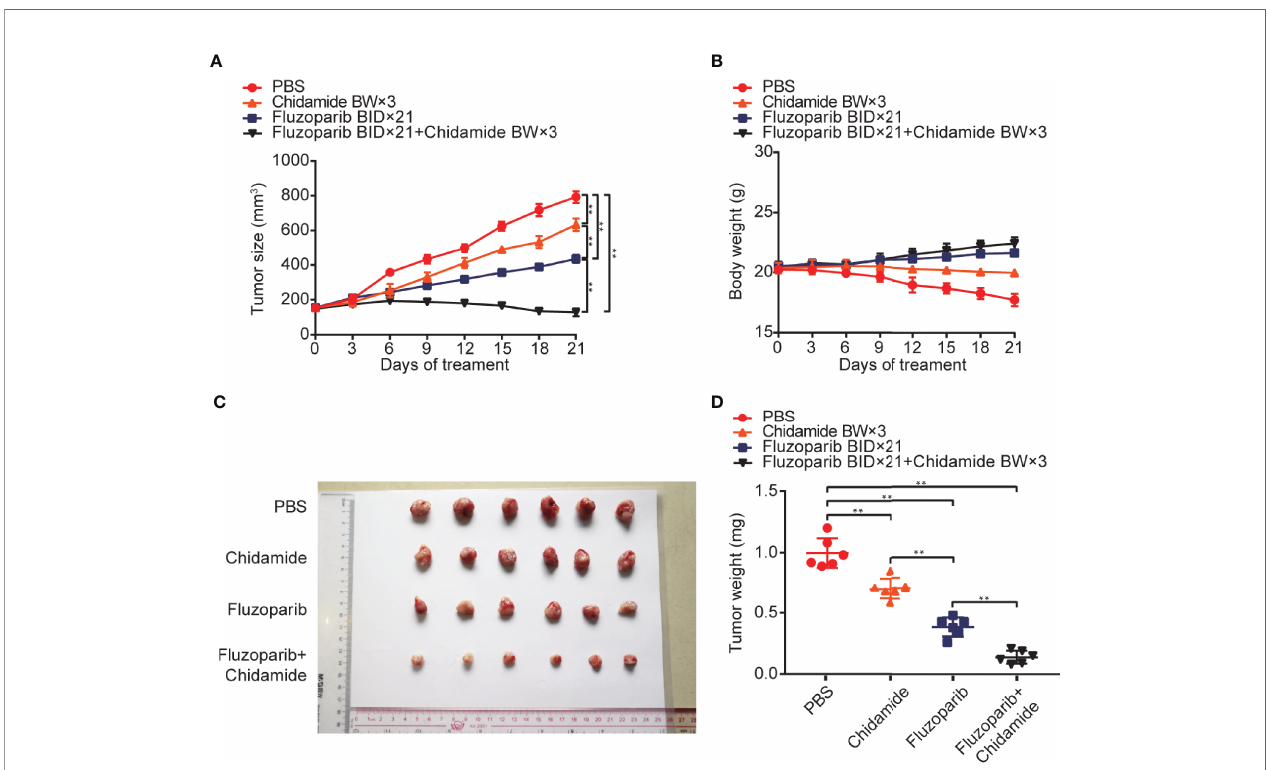
FIGURE 4 | In vivo anticancer effects of fl uzoparib and chidamide in fl uzoparib-resistant HCC1937 breast cancer xenograft models. Randomly grouped nude mice were treated with PBS, fl uzoparib (25 mg/kg/bid), chidamide (5 mg/kg/bw), or a combination treatment ( fl uzoparib 25 mg/kg/bid + chidamide 5 mg/kg/bw) for 21 days. (A, B) Tumor growth ratio curve and body weight change every 3 days after the onset of treatment. (C, D) Photographs of the exfoliated tumors and weight obtained on day 21 of treatment. ** p <